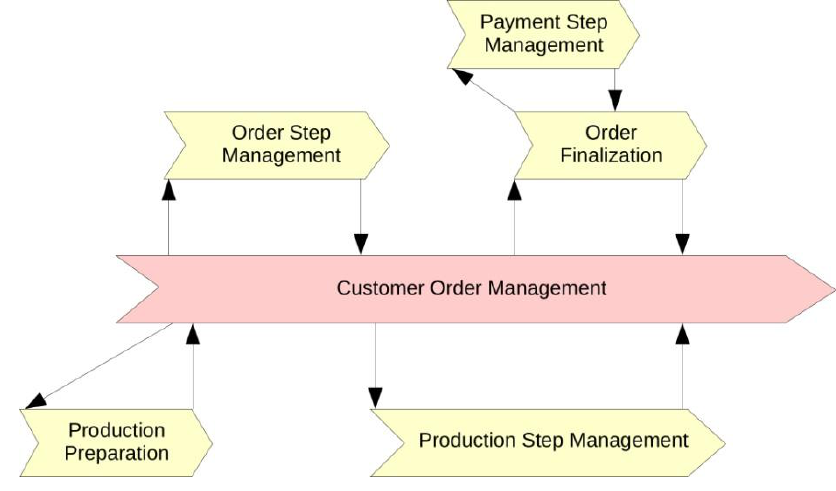
Figure 6. Process Map (2nd and 3rd Normal